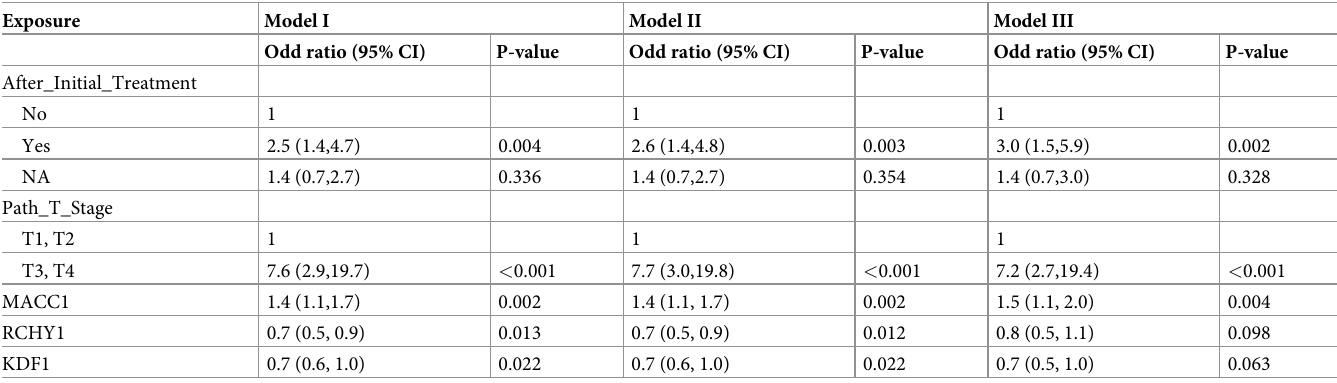
with lymphatic metastasis; while the expression level of RCHY1 and KDF1 were negative with lymphatic metastasis (Table 3). Table 3. Multivariate logistic regression model for risk factors associated with lymphatic metastasis (N = 297).